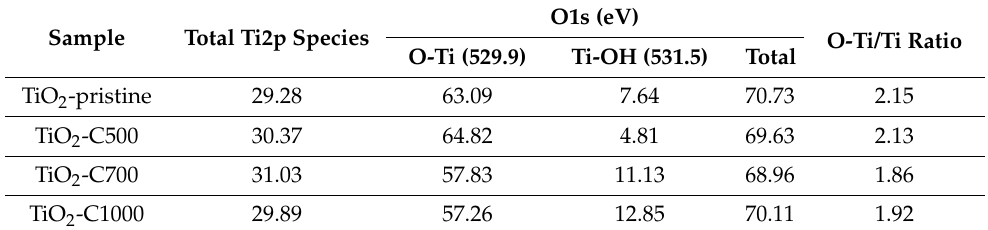
Table 2. Surface elemental composition of TiO 2 samples.